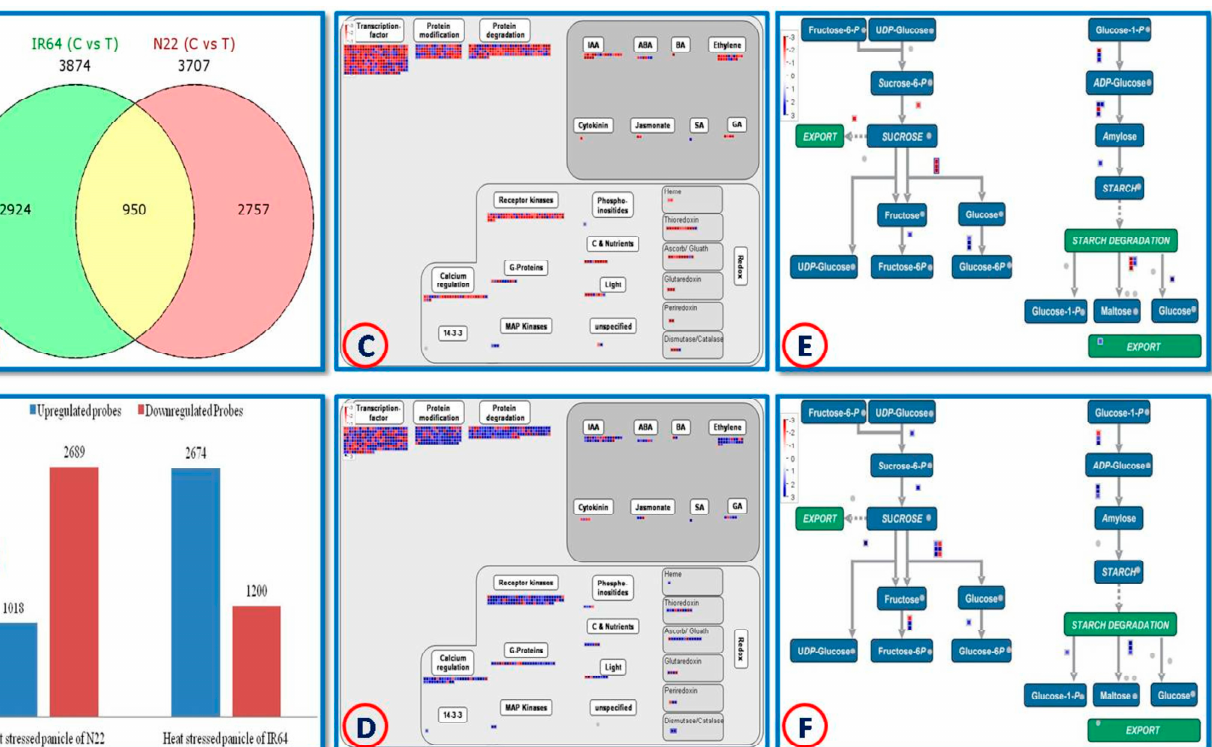
Figure 1. Microarrayresults of differentially expressed genes (DEGs) in the panicles of IR64 and N22 under eight days of heat stress. ( A ): Number of genotype-specific and common DEGs in IR64 and N22 in response to heat stress; ( B ): number of up-regulated and down-regulated genes in IR64 and N22 in response to heat stress; ( C ): MapMan overview of the major pathways of the DEGs of heat-stressed N22 panicles; ( D ): MapMan overview of the major pathways of the DEGs of heat-stressed